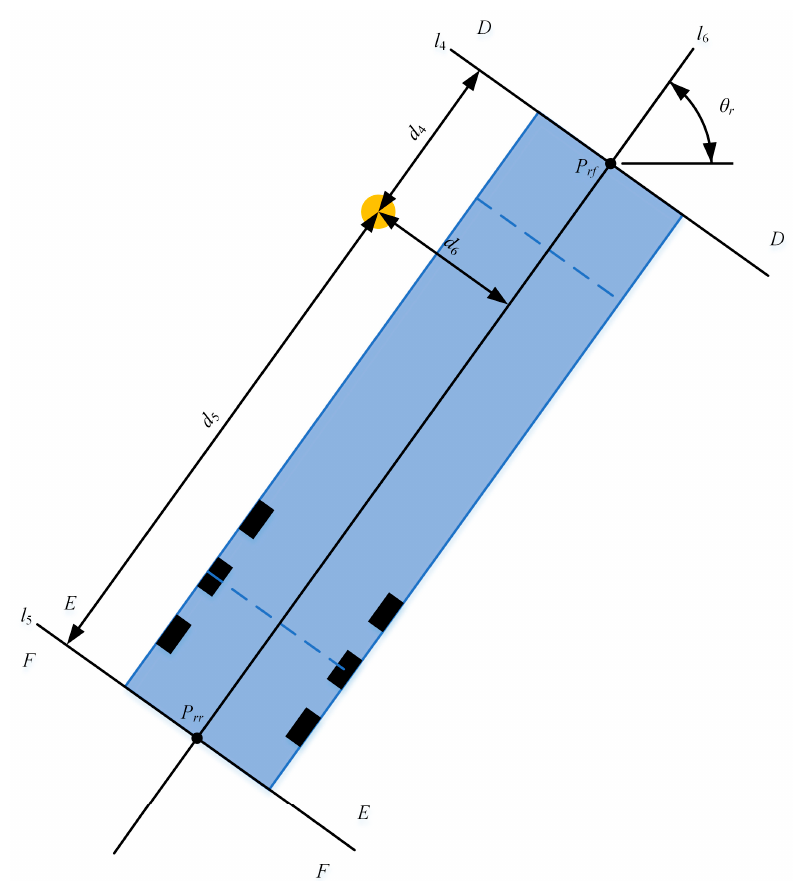
Figure 6. The obstacle avoidance model of the trailer